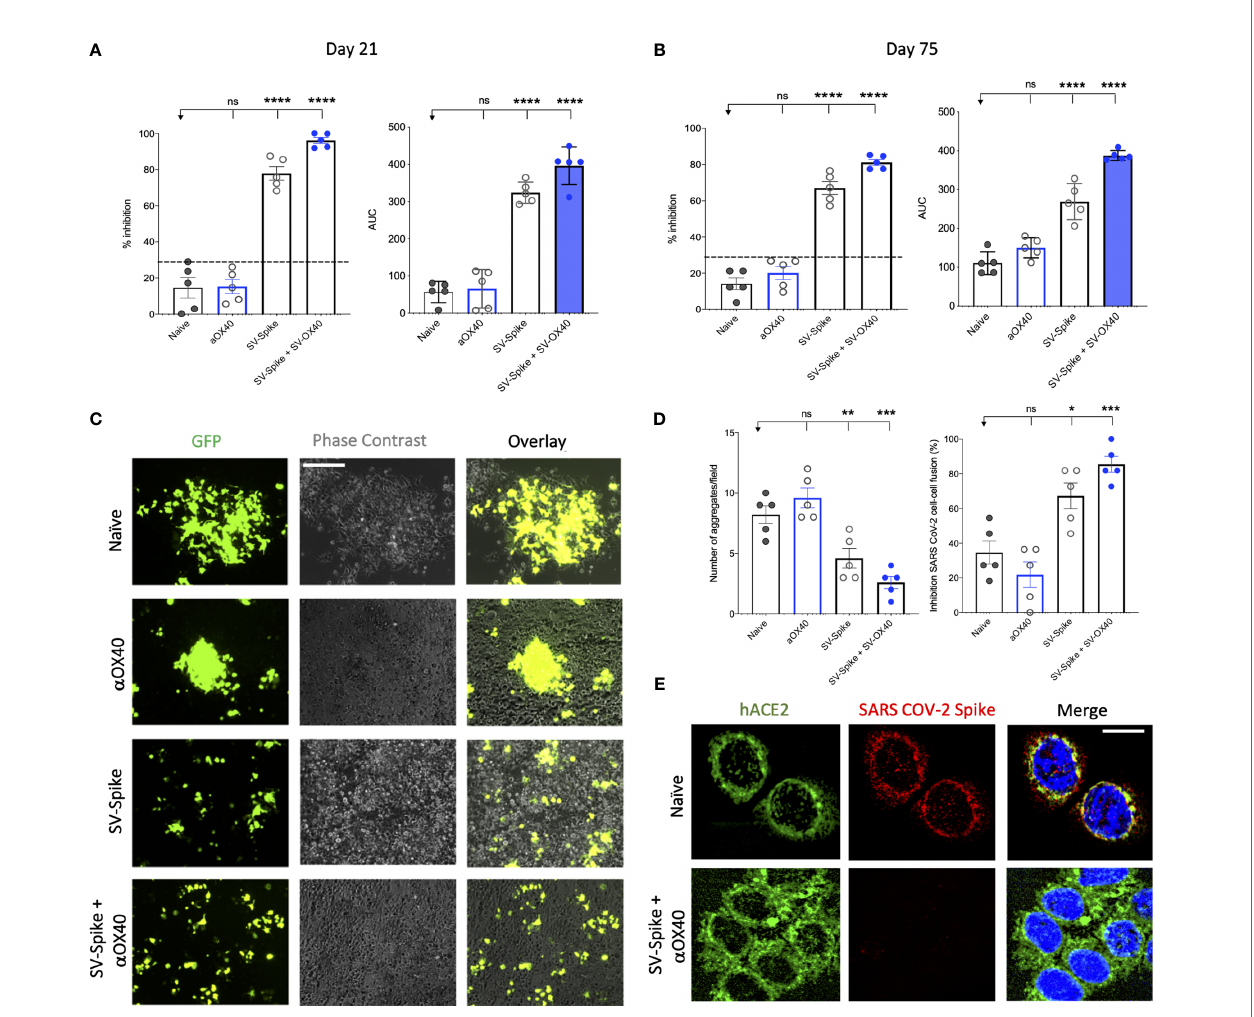
FIGURE 3 | Blockade of SARS-CoV-2 spike-hACE2 binding and spike protein-mediated cell – cell fusion by anti-SARS-CoV-2 spike neutralizing antibodies. (A, B) In the assay, anti-SARS-CoV-2 neutralizing antibodies from immunized C57BL/6J mice, block recombinant Spike protein from binding to the hACE2 protein pre-coated on an ELISA plate. Percentage of inhibition distributed along y-axis of SARS-CoV-2 spike – hACE2 interaction for the indicated reciprocal plasma dilutions by mouse sera collected at (A) 21 and (B) 75 days post vaccination with Sindbis expressing SARS-CoV-2 spike (SV.Spike), SV.Spike in combination with a OX40 and a OX40 alone compared to the naive group. Area under the curve (AUC) values of serum antibodies were calculated from reciprocal dilution curves in antibody detection assay. The data presented are the mean of 5 biological replicates with two technical replicates. Statistics were performed using a One-way ANOVA with the Bonferroni correction in Graphpad Prism. n.s. > 0.05; *P<0.05; **P<0.01; ***P<0.001; ****P<0.0001. (C) Images of SARS-CoV-2 spike-mediated cell – cell fusion inhibition on 293T/ACE2 cells by sera from C57BL/6J vaccinated mice. SARS-CoV-2 spike-transfected 293T were incubated with mice serum at 1:100 dilution and applied onto 293T/ACE2 cells for 24 h. Scale bar: 100 µm. (D) Quanti fi cation of the number aggregates (left panel) and inhibition of cell – cell fusions (right panel) induced by SARS-CoV-2 spike following pre-incubation with naïve, SV.Spike, SV.Spike+ a OX40 and a OX40 alone are shown. N = 5 biological replicates with two independent technical replicates. One-way ANOVA with Bonferroni correction *P<0.05, **P<0.01, and ***P<0.001. (E) Representative confocal images of 293T/ ACE2 cells treated with serum from Naïve and SV.Spike+ a OX40-immunized mice pre-incubated with SARS-CoV-2 spike recombinant protein and stained for hACE2 (green), SARS-CoV-2 spike (red), and DAPI (blue). Scale bar: 20 m